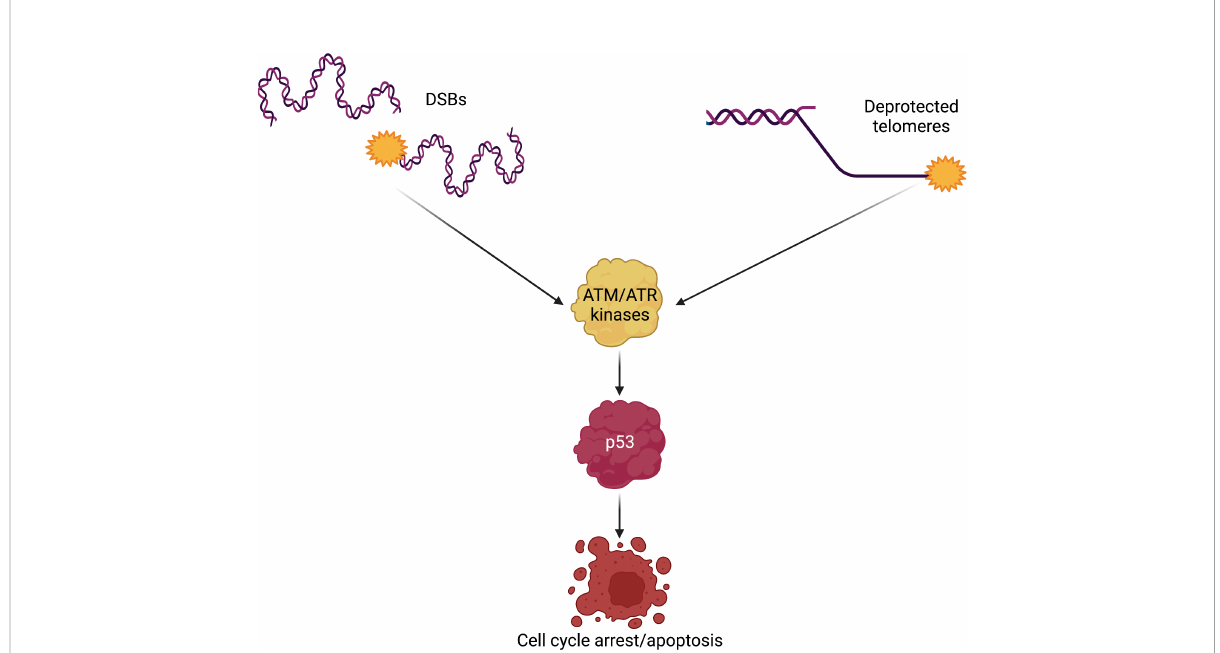
FIGURE 3 DSBs and deprotected telomeres trigger similar DNA damage signaling. The members of the PIKK family of kinases are activated by DNA damage. Both DSBs, generated either by exogenous or endogenous sources, and deprotected telomeres are recognized as DNA damage that must be repaired. Excessive DNA damage leads to activation of p53, the guardian of the genome. p53 is a transcription factor with the capacity to control the activation of cell cycle arrest genes when DNA damage is repairable; however, unsurmountable amounts of DNA damage will lead the cell into apoptosis, also in a p53-dependent manner. p53-mediated apoptosis in response to DNA damage may be a common mechanism leading to HSPCs demise in Fanconi anemia and DC/TBD. DSBs, double-strand breaks; DC/TBD, dyskeratosis congenita/Telomere biology disorders; HSPCs, hematopoietic stem and progenitor cells; PIKK, phosphatidylinositol-3 kinase-related